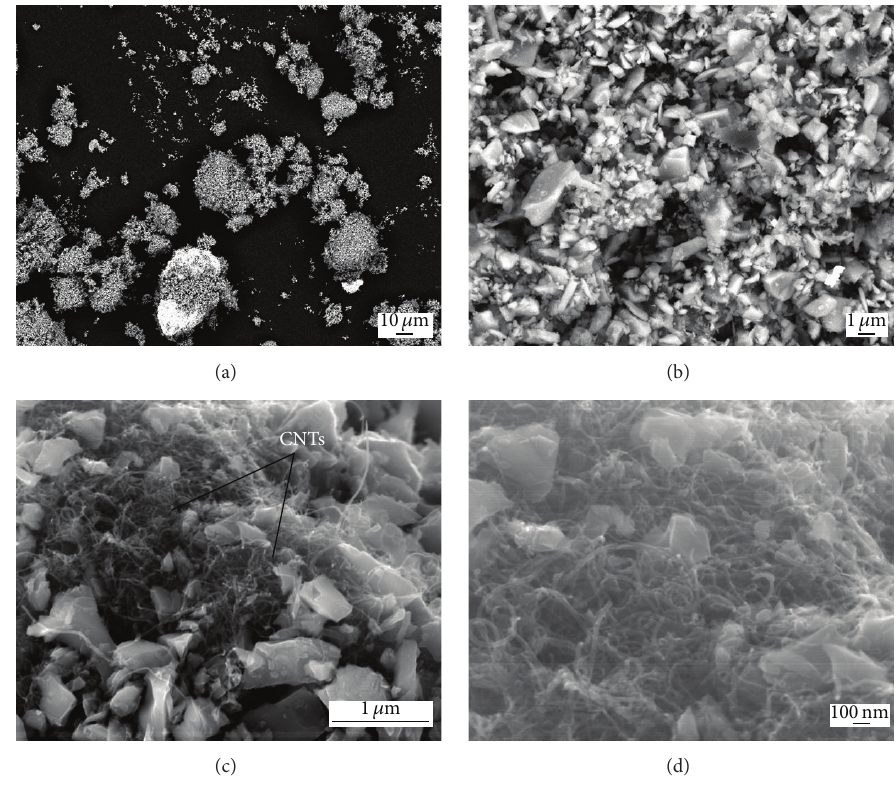
Figure 1: SEM images showing the powder mixtures of SiC-4wt% CNTs-4wt% TaC-1wt% B 4 C.